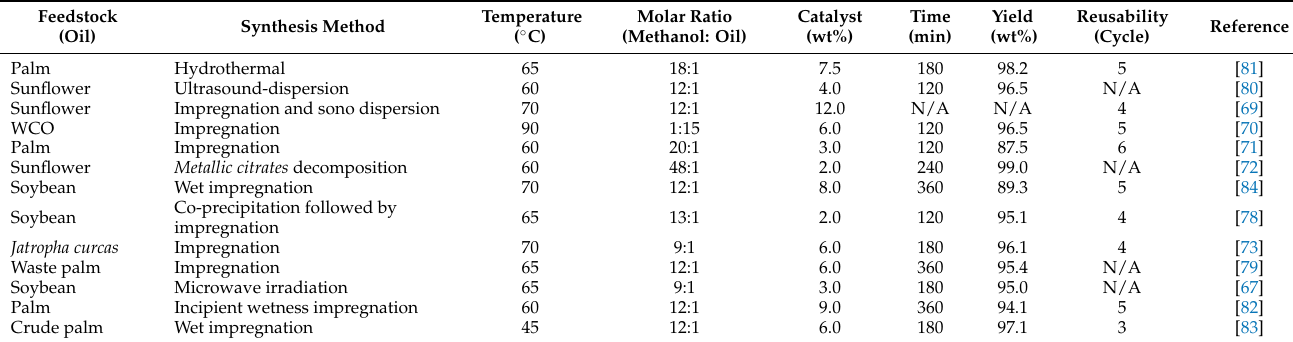
Table 4. Utilization of supported CaO catalysts in